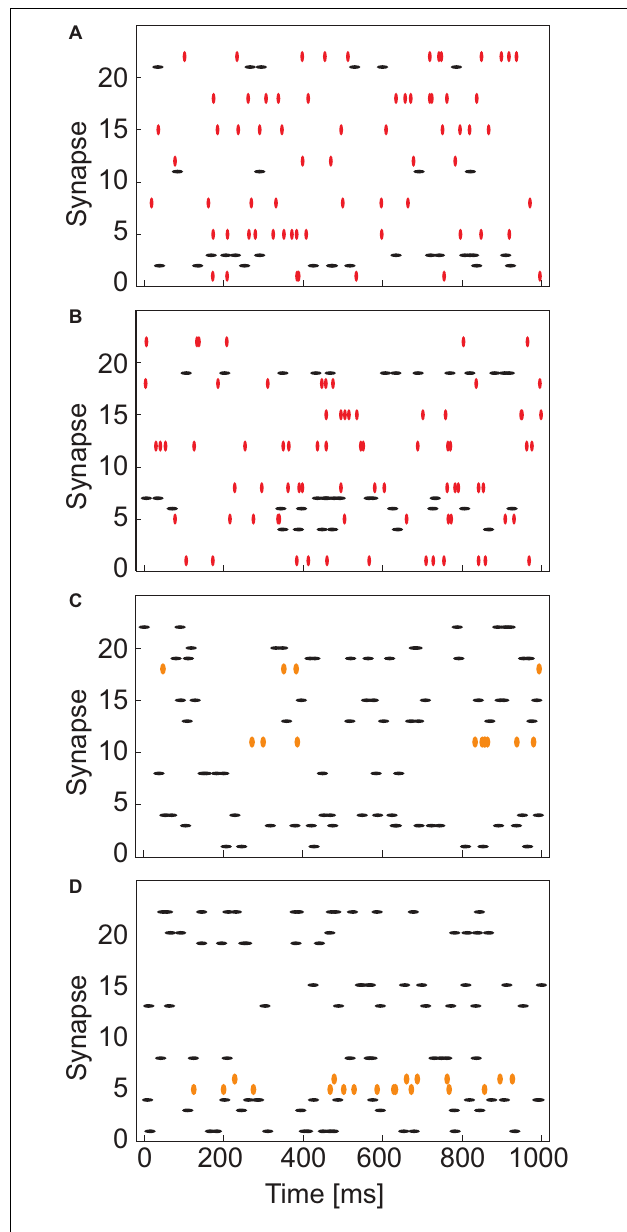
FIGURE 3 | Exemplary raster plots showing the Poisson distributed spike trains which are applied to the different synapses for 1 s. (A,B) Show an exemplary pattern+ and pattern– , respectively, with an overlap of seven between the patterns. The overlapping synapses (1, 5, 8, 12, 15, 18, 22) are marked as red vertical symbols. (C,D) Show two noisy pattern+ examples. Based on the ideal pattern (not shown) two synapses were flipped (11 and 18 in C and 5 and 6 in D ). The flipped synapses are marked as orange vertical symbols.